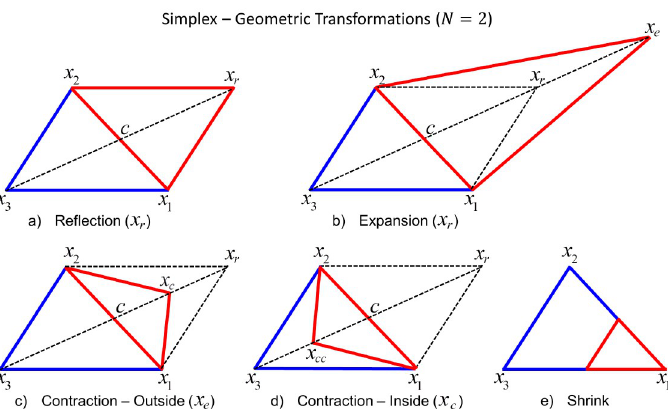
Fig 4. Movements defined in the original Nelder-Mead Simplex. (a) Reflection of X 3 , given by vertex X r , (b) , (c) Outside contraction, given by vertex X , (d) Inside contraction, defined by Expansion, represented by vertex X e c vertex X cc and (e) shrinkage, represented by a smaller triangle of vertices. Figure adapted from: http://www. scholarpedia.org/article/Nelder-Mead_algorithm.